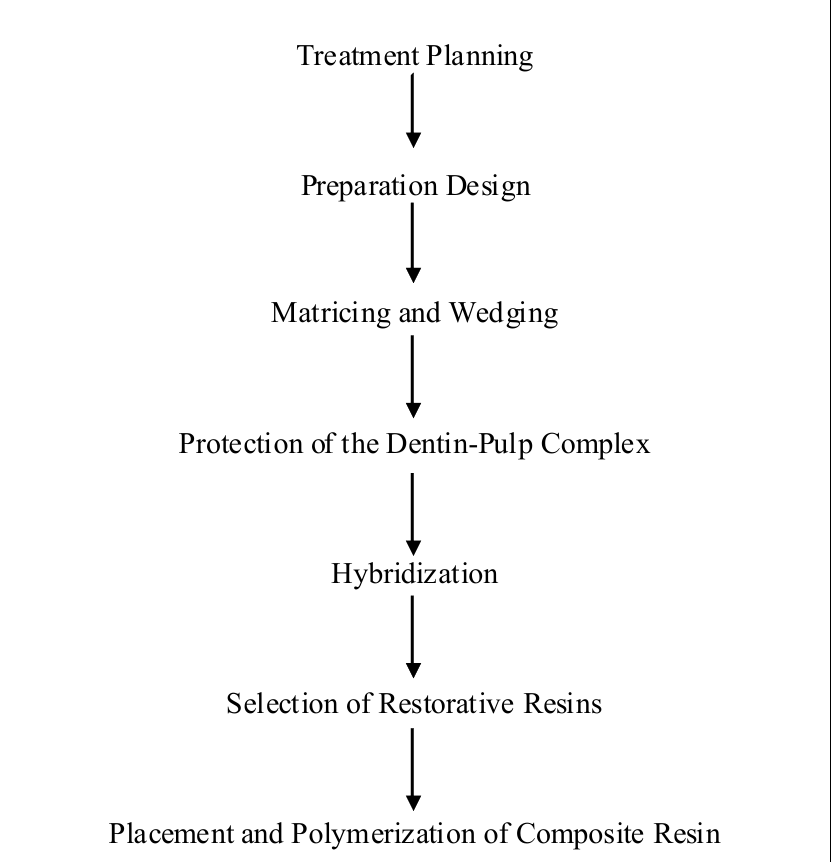
Figure 1. Clinical procedures of a direct resin composite